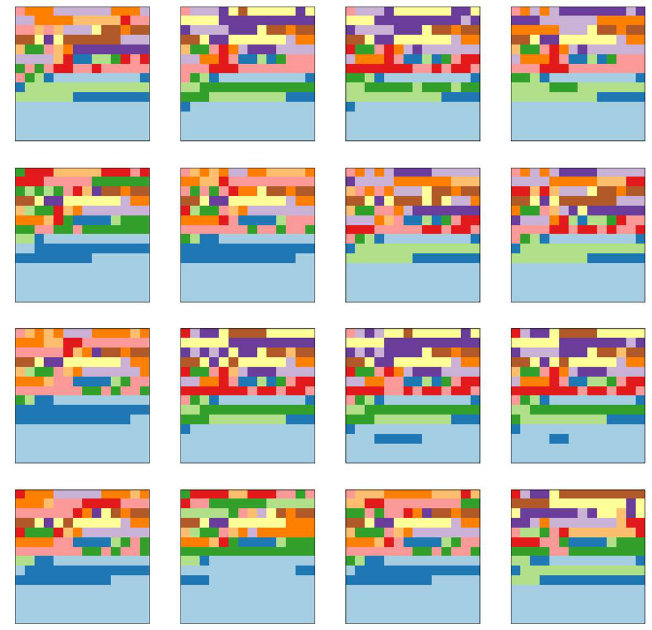
Figure 5. 2D spectral feature maps of 16 classes in the Indian Pines dataset.